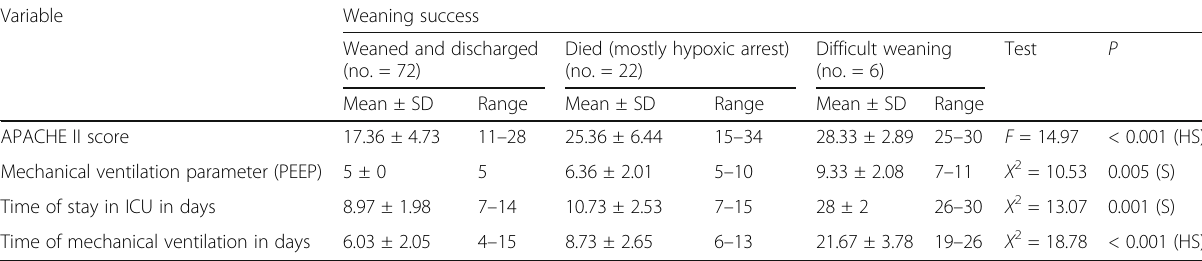
Table 3 Relation between weaning success and parameters of admission in ICU including APACHE II score